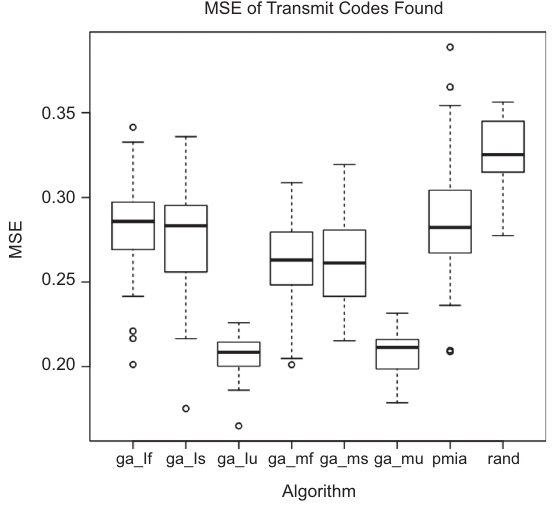
Figure 3 Length 58 2 PSK Box Plot Results.